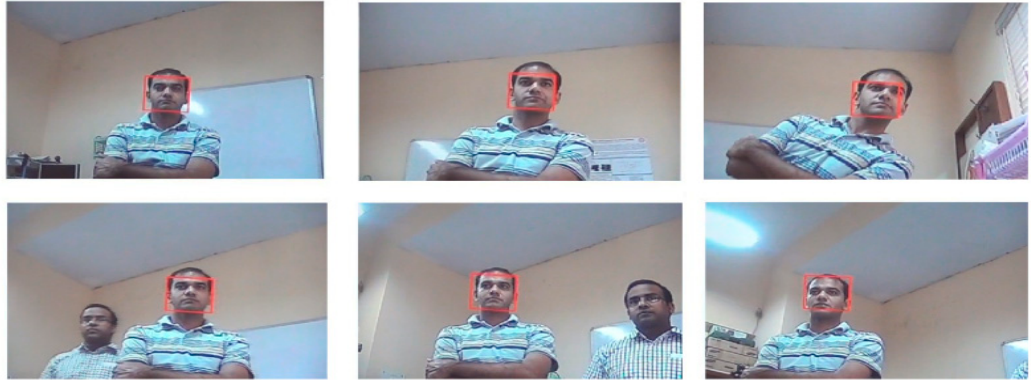
Figure 16. Frame sequence showing object tracking in scenes that change due to camera movement and presence of other moving objects in the scene.